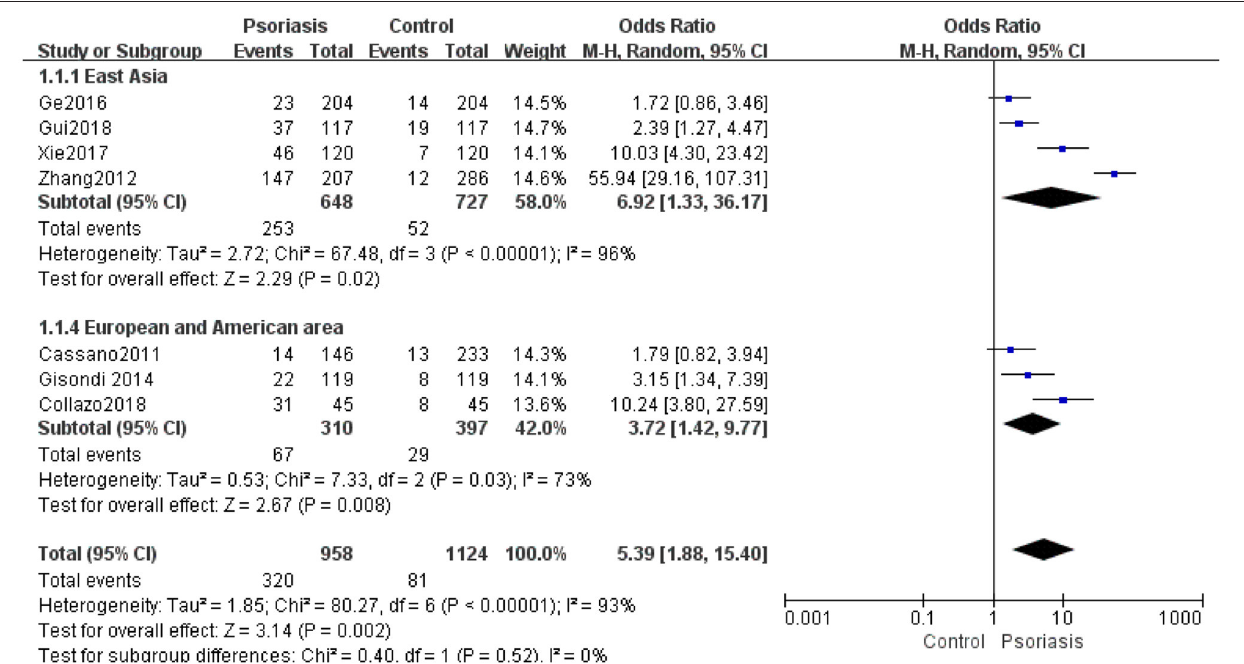
FIGURE 5 | Meta-analysis of the prevalence of hyperuricemia in psoriasis patients vs. controls. OR for psoriasis in patients with hyperuricemia compared with total patients. The point estimate (center of each blue square) and statistical size (proportional area of the square) are represented. The horizontal lines indicate the 95% confidence intervals. The pooled OR (diamond) was calculated using a random-effects model. OR, odds ratio.